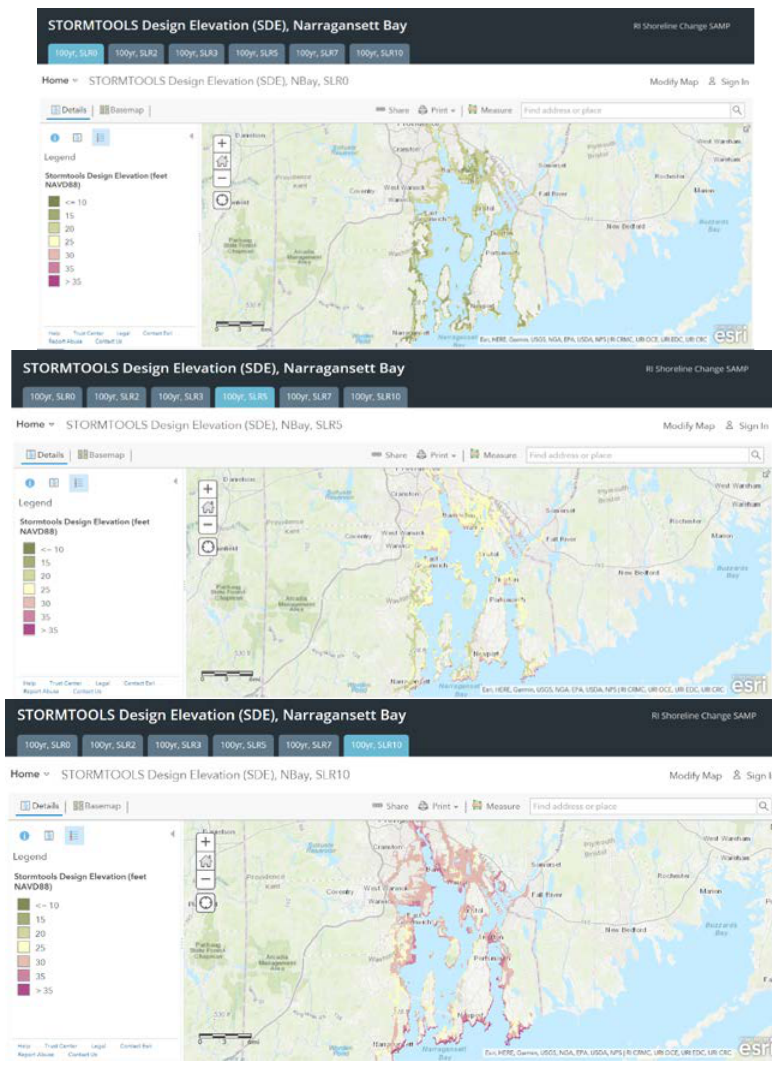
Figure 11. Impact of SLR on Narragansett Bay SDE maps, cases shown are 0, 5 ft (1.52 m), and 10 ft (3.05 m) SLR (upper, middle, and lower panel,